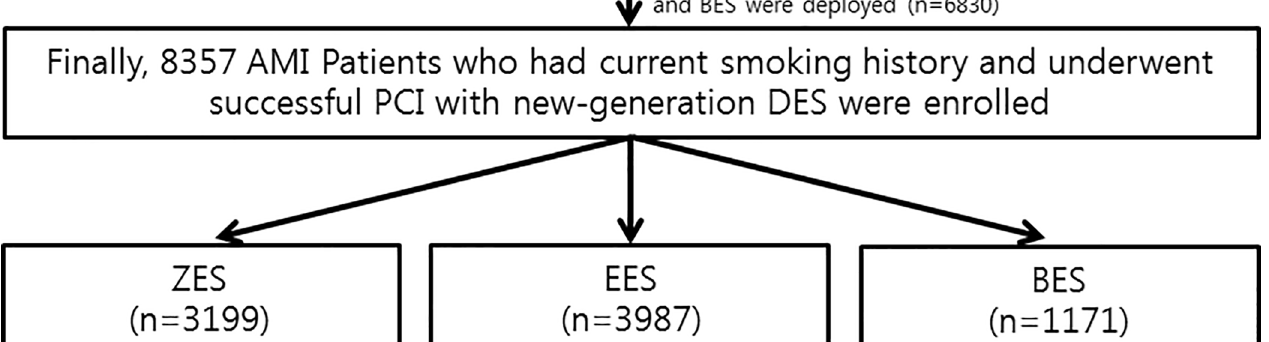
Fig 1. Flow chart. AMI, acute myocardial infarction; KAMIR, Korea Acute Myocardial Infarction Registry; PCI, percutaneous coronary intervention; BMS, bare-metal stent; CABG, coronary artery bypass graft; DES, drug-eluting stents; ZES, zotarolimus-eluting stents; EES, everolimus-eluting stents; BES, biolimus- eluting stents. (cid:3) Non-smoker was defined as who did not regularly smoke at any time. † Ex-smoker was defined as who had stopped smoking for more than 1 year before the index PCI